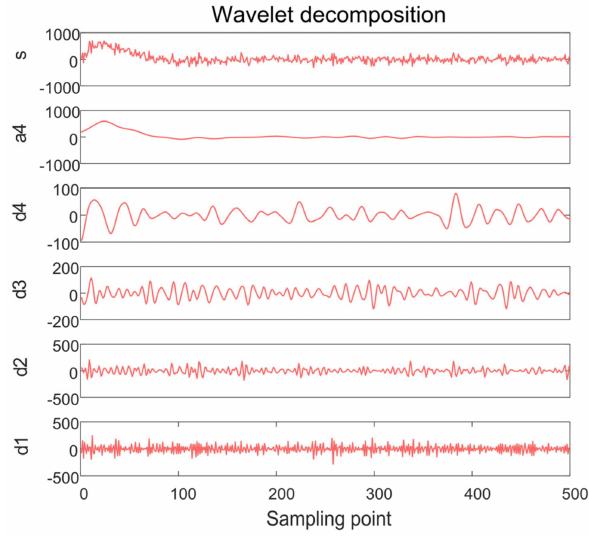
Figure 10. Simulated signal wavelet decomposition.